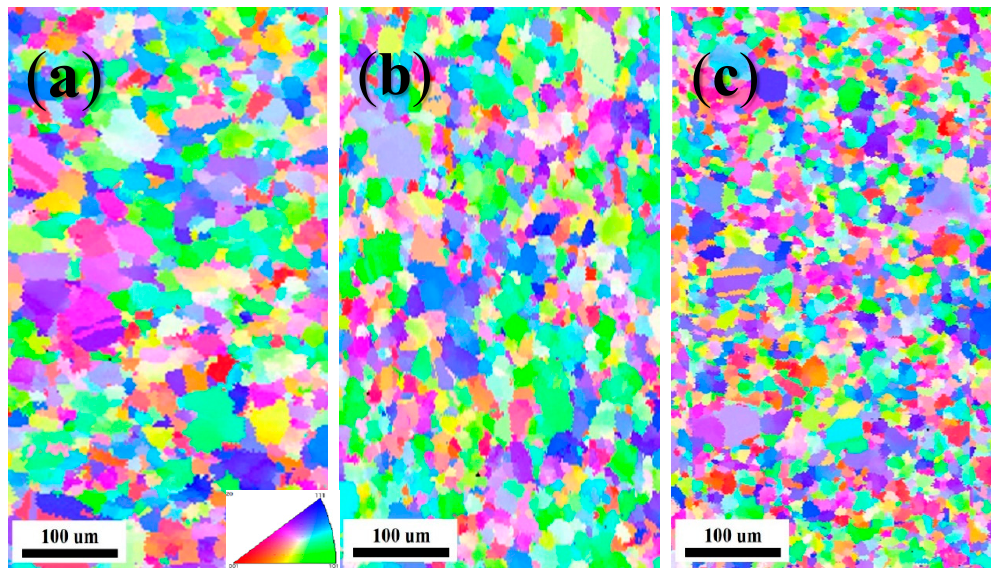
Figure 5. Inverse pole figure image of Al–x wt.% TiC nanocomposite: x = ( a ) 0, and ( b ) 6 and ( c ) 12.